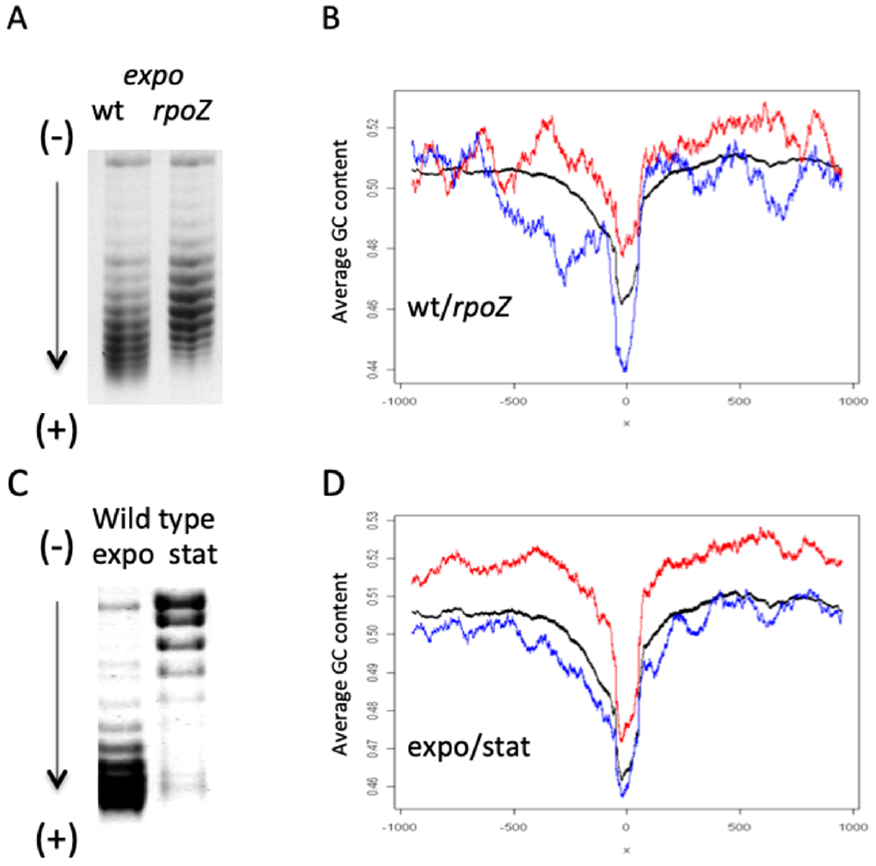
Figure 4. Relationship between DNA topology and the thermodynamic stability of transcribed sequences. ( A ). High-resolution agarose gel-electrophoresis of DNA plasmids isolated from exponentially growing wild-type and rpoZ mutant cells. More negatively supercoiled topoisomers migrate faster in the gel. Note the relaxation of DNA in rpoZ mutant. ( B ). Comparison of the DNA thermodynamic stability of promoter sequence context in wild type and rpoZ mutant cells. Position of transcription start site (TSS) is indicated by 0. Average DNA GC-content of the promoter sequence context for all genes (black curve). Average DNA GC-content of genes up-regulated in wild-type and rpoZ mutant cells during exponential phase is indicated by red and blue curves, respectively (data from [39]). ( C ). High-resolution agarose gel-electrophoresis of plasmids isolated from exponentially growing (expo) and stationary (stat) E. coli CSH50 cells. Note the relaxation of DNA in stationary phase. ( D ). Comparison of the DNA thermodynamic stability of promoter sequence context in exponentially growing (expo) and stationary (stat) E. coli CSH50 cells. The TSS position is indicated by 0. Average DNA GC-content of the promoter sequence context for all genes (black curve). Average DNA GC-content of genes up-regulated in exponentially growing and stationary cells is indicated by red and blue curves,